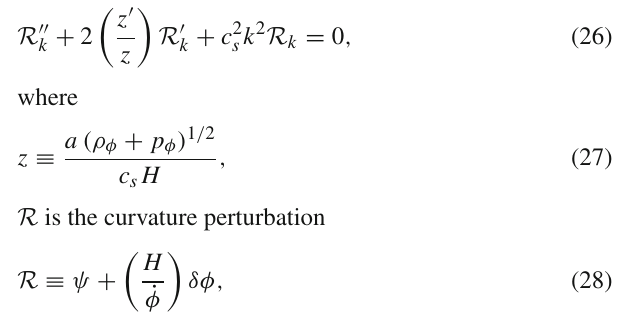
Fig. 2 Left The equation of state for the scalar field w φ as a function of scale factor for V (φ) ∼ φ 2 ( solid line ). The dashed line is for equation of state described by (18) for (cid:9) (cid:4) = 0 . 7 and (cid:9) 0 X = 0 . 3. We have set